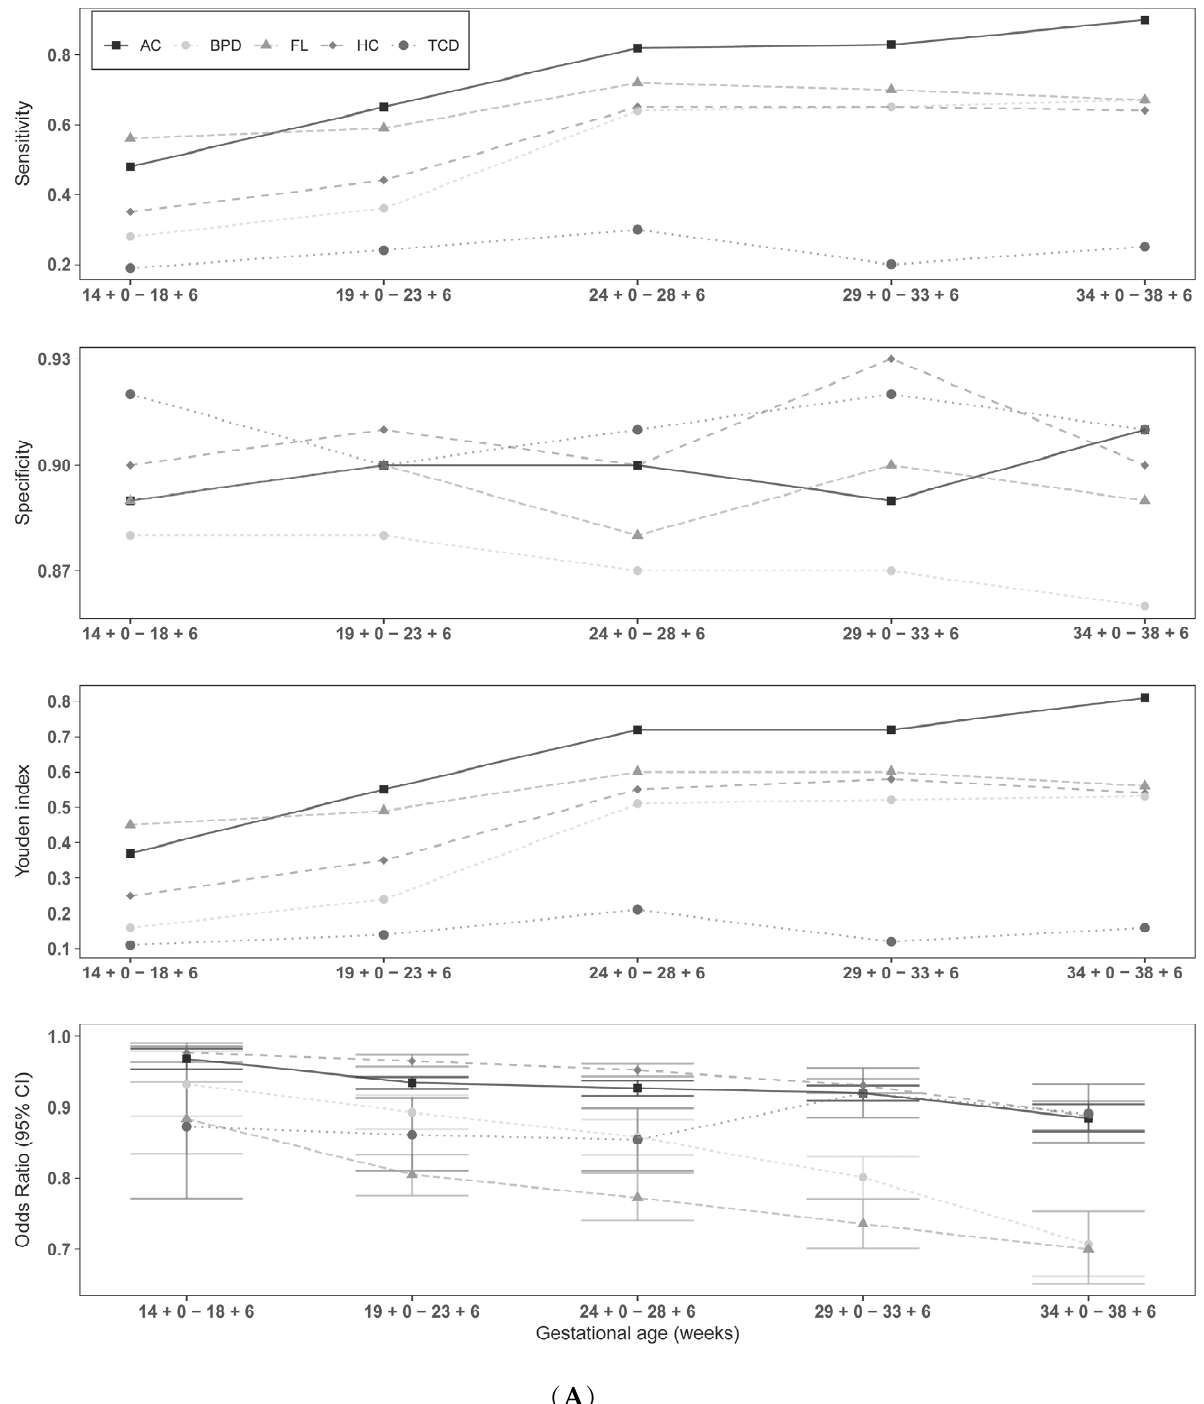
Figure 3A,B, are presented in Supplementary Tables S5 and S6. Supplementary Tables S5 and S6 summarize the accuracy of the cutoff values for predicting SGA and FGR fetuses, respectively.